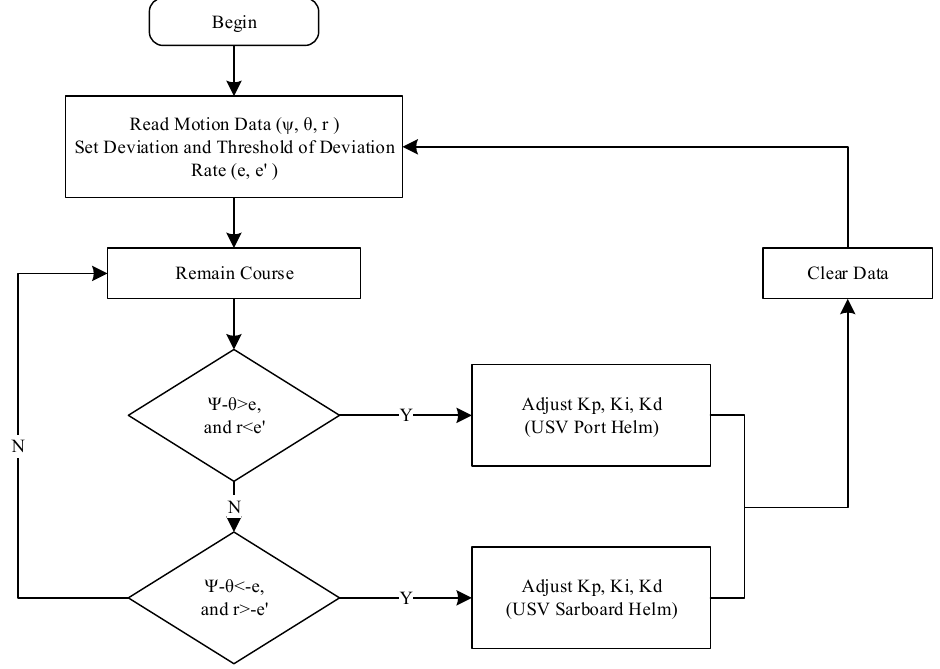
Figure 8. Flow chart of Human Simulated Intelligent Control (HSIC); θ is the azimuth angle, ◦ ; r is the yaw rate, rad / s; e (cid:48) is the error change